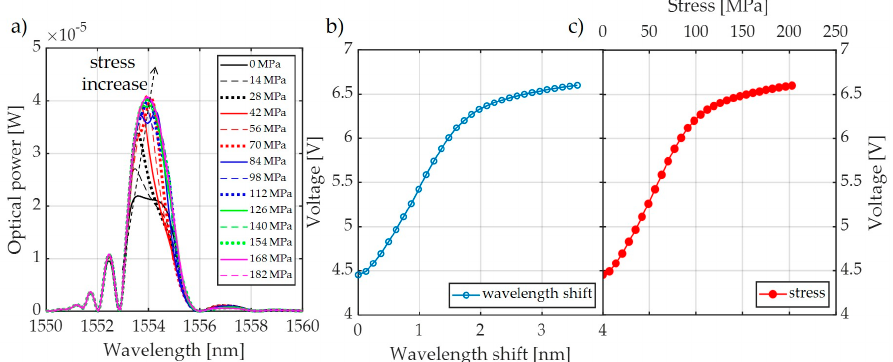
Figure 15. Measurement results using the interrogator presented in Figure 3a for the FBG + FBGF3 matched gratings pair: ( a ) change in the shape of the system output signal; ( b ) wavelength shift processing characteristics; ( c ) characteristics of the power line conductor stress conversion to changes in the voltage on the photodetector.